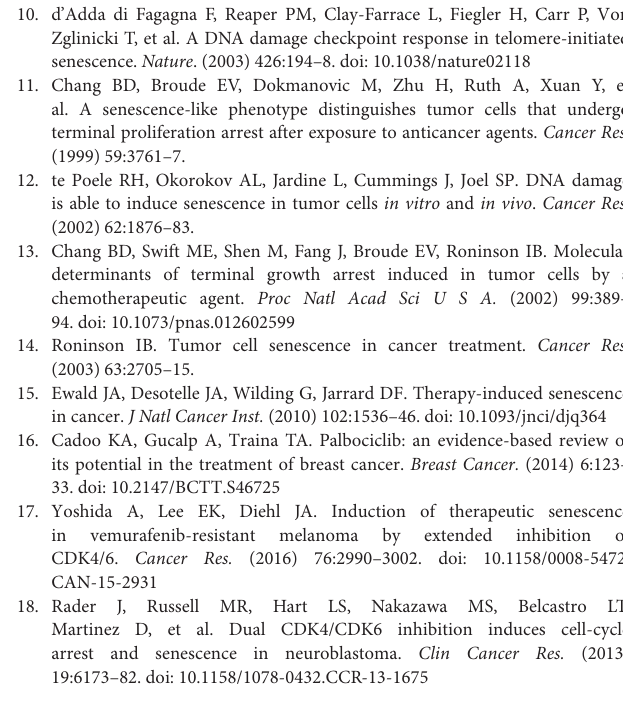
Supplementary Table 2 | Clinicopathological characteristics of the patient cohort. Supplementary Table 3 | Cutoff values for survival analysis as calculated using a modification of the Cutoff Finder from